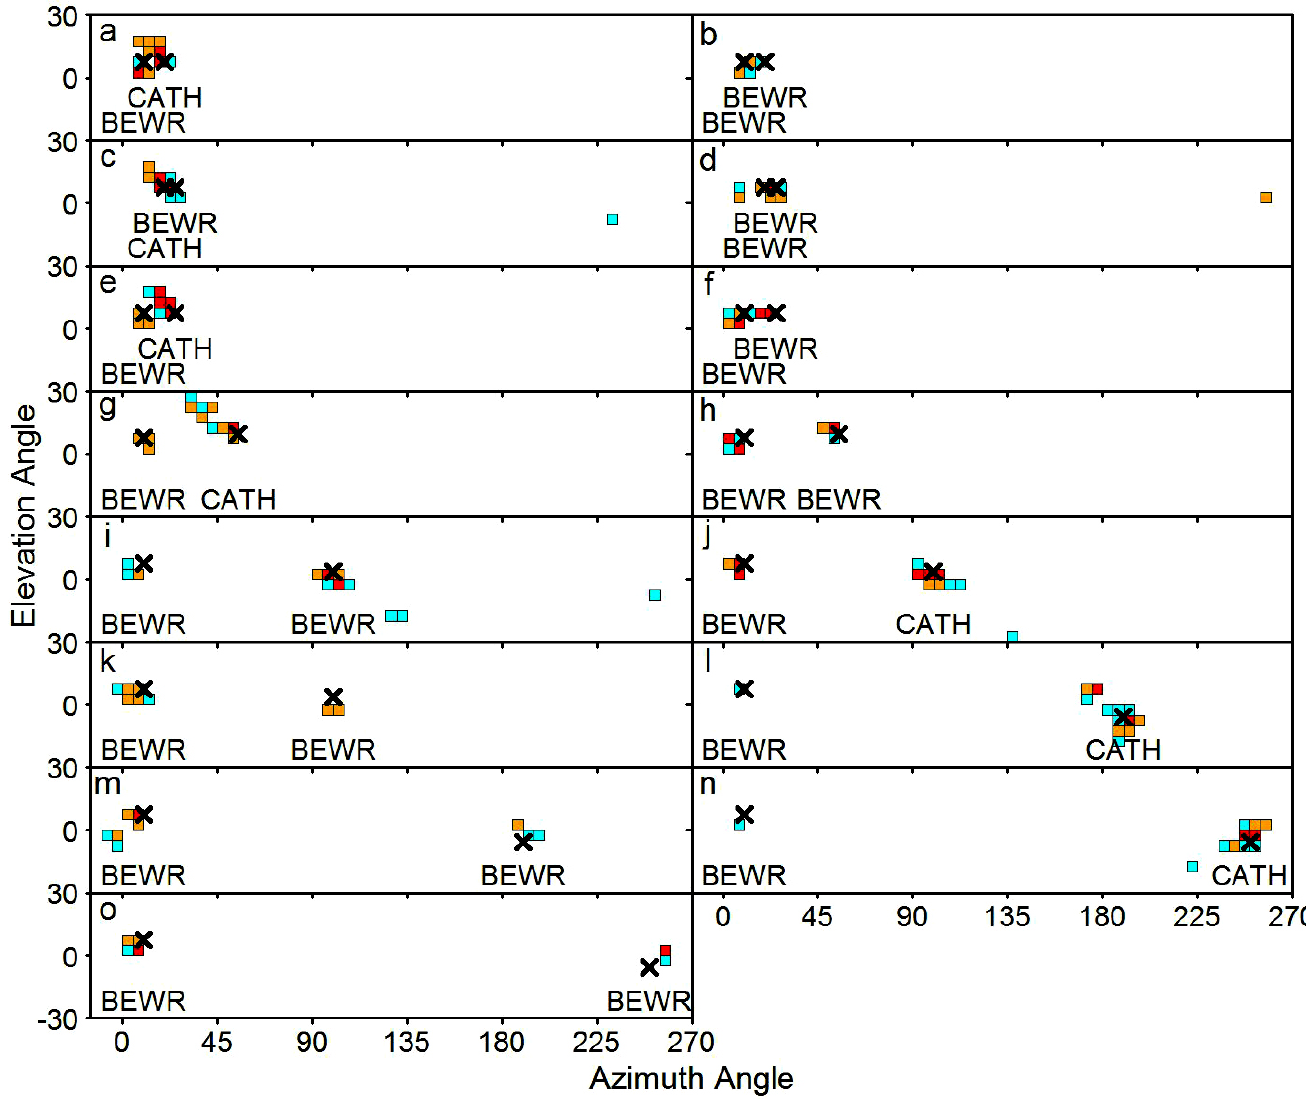
Fig. 3 . Visual representation of the results of experiments testing the ability of the microphone system to determine the direction-of- arrival (DOA), in both the azimuth and elevation directions, to two sources being broadcast at the same time from varying directions. All sounds were broadcast from speakers placed 15 m from the microphones. Xs denote the DOA of each source, as measured in the field, and the species name is indicated beneath each X. Colored rectangles indicate the number of sounds estimated to have originated from each direction (blue: 1 sound; orange: 2–5 sounds; red: > 5 sounds). DOA estimates for 535 sounds are shown. Though DOA was estimated with a resolution of 1°, rectangles are shown with a resolution of 5° for